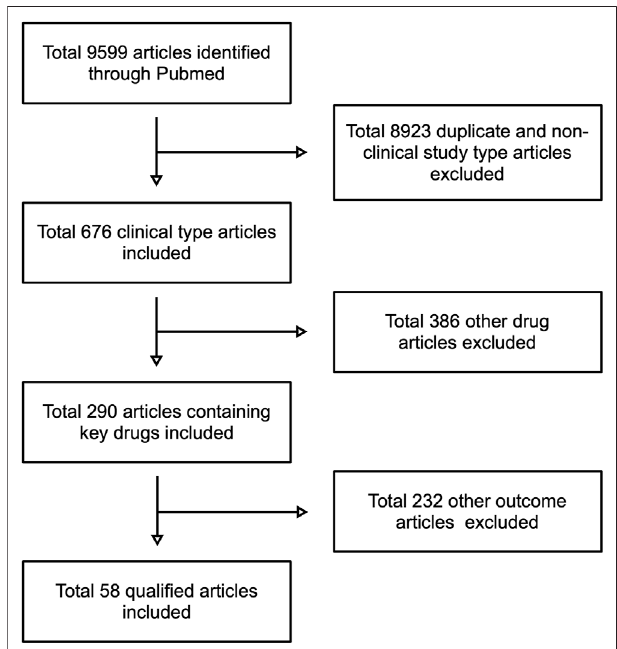
FIGURE 1 | The screen and fi ltering processes for this